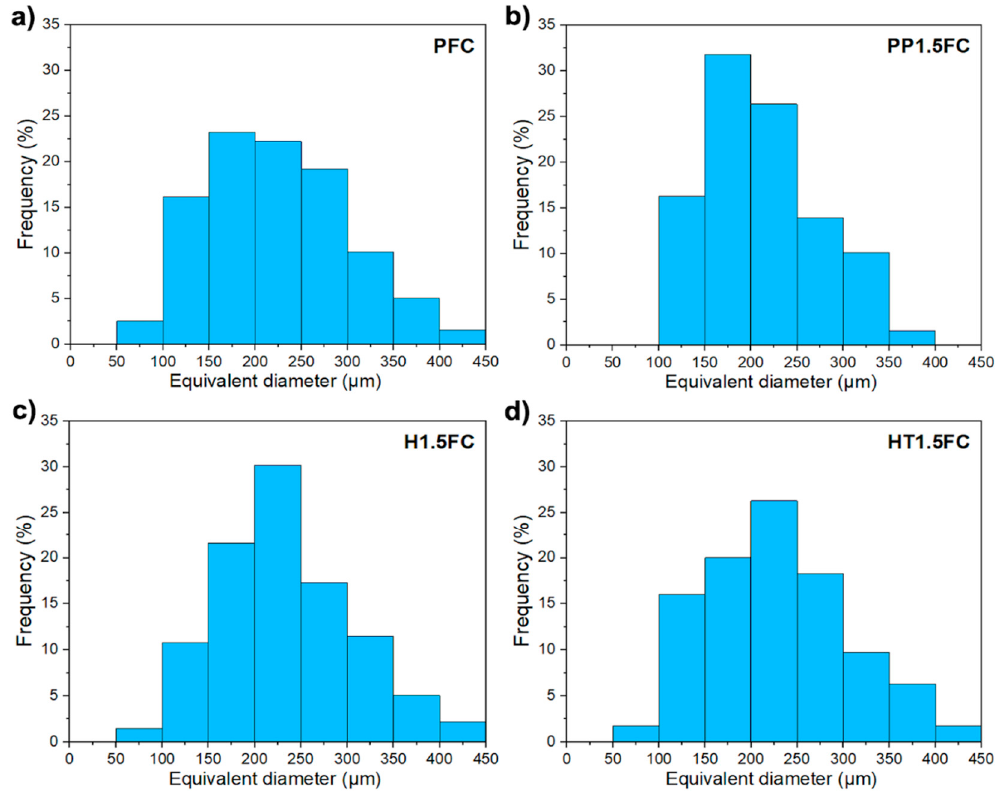
Figure 8. Frequency histograms of the air-void diameters of foamed concrete mixtures: ( a ) PFC; ( b ) PP1.5FC; ( c ) H1.5FC and ( d ) HT1.5FC.